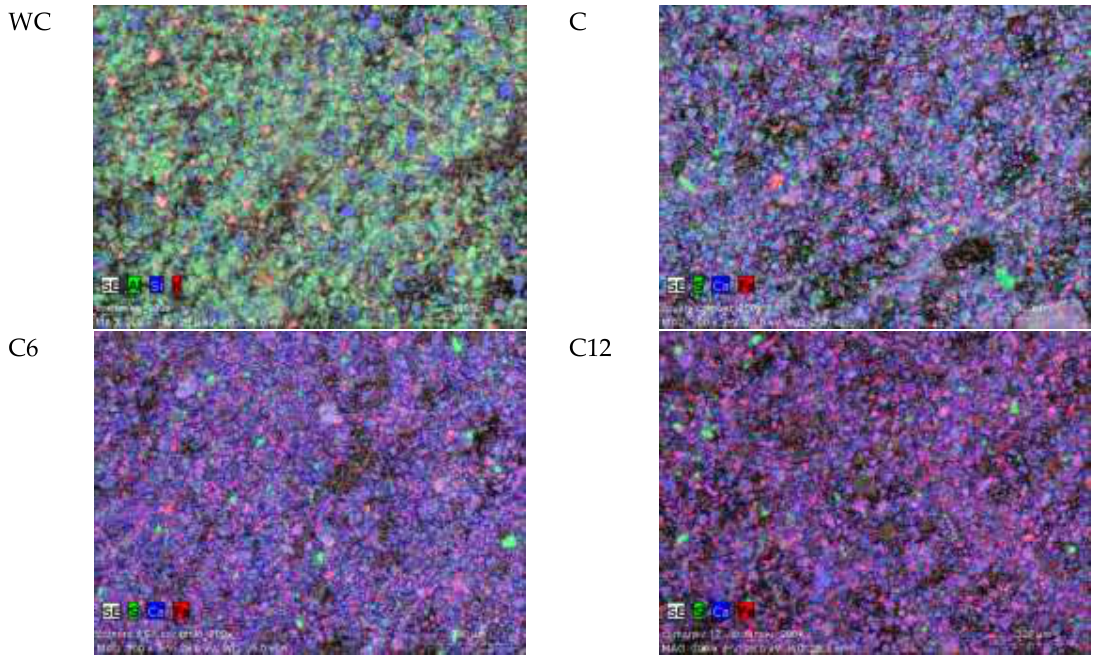
Figure 6. SEM photos (artificial colors) of white ceramic and cements. Table 3. Initial setting time and fineness of tested cements.